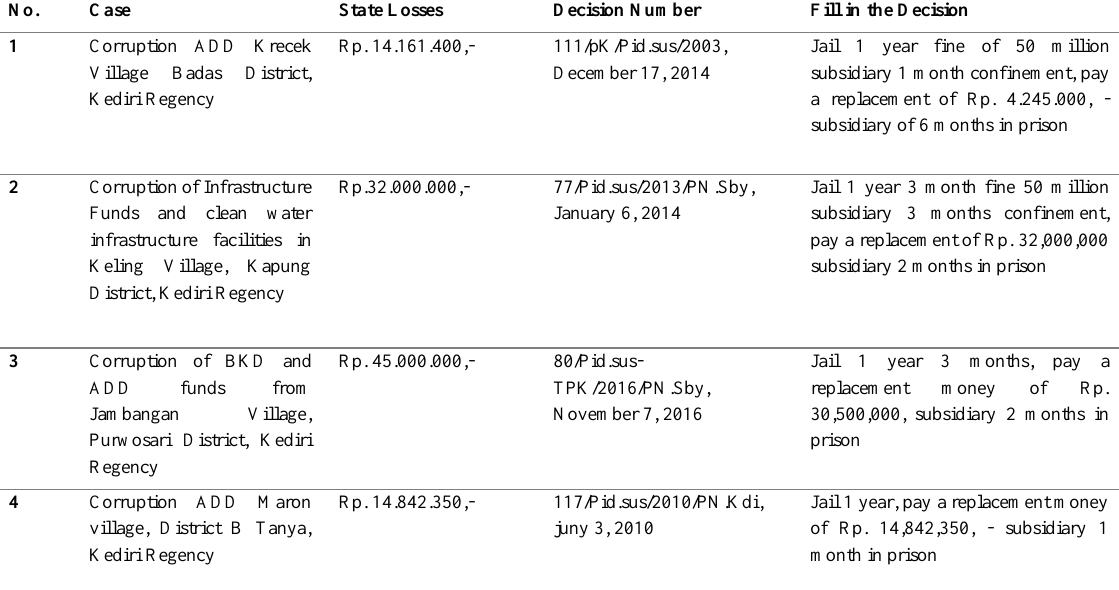
Table 1: Corruption with loss less than Rp 50.000.000,-